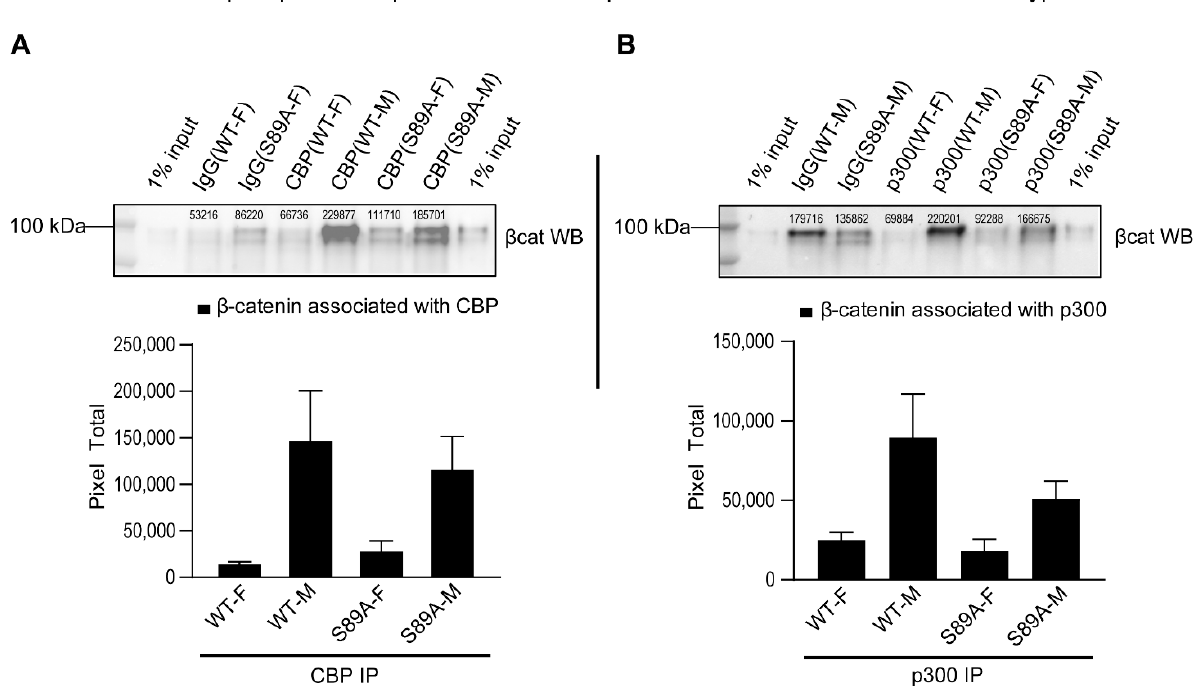
Figure 2. p300 S89A mice show differential usage of Kat3 coactivators CBP and p300 by β -catenin. Co-immunoprecipitation of β -catenin with CBP ( A ) or p300 ( B ) in S89A and WT mouse intestinal crypt cells. Control (IgG) antibody and anti-CBP antibody or anti-p300 antibody were used for immunoprecipitation followed by immunoblotting for β -catenin. Numerical values above protein bands indicate densitometric quantitation of β -catenin associated with CBP or p300. Bar graphs show densitometric quantitation normalized to respective control. Data in bar graphs (mean ± s.e.m.) representative of three independent experiments are shown. S89A, p300 S89A; WT, wild type; F, female; M, male; β cat, β -catenin; IP, immunoprecipitation. Whole immunoblots corresponding to immunoblot data are included in Figure S3.